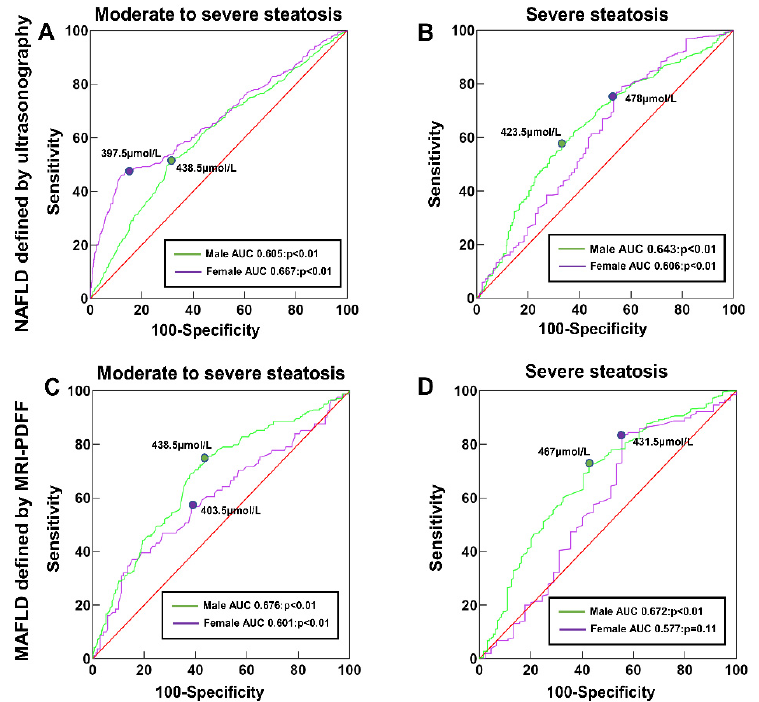
Figure 2. ROC curve of the SUA level as a predictor of steatosis severity in male and female NAFLD or MAFLD: ( A ) moderate-to-severe steatosis, ( B ) severe steatosis, ( C ) moderate-to-severe steatosis (21.7% > LFC ≥ 16.3%), and ( D ) severe steatosis (LFC ≥ 21.7%).